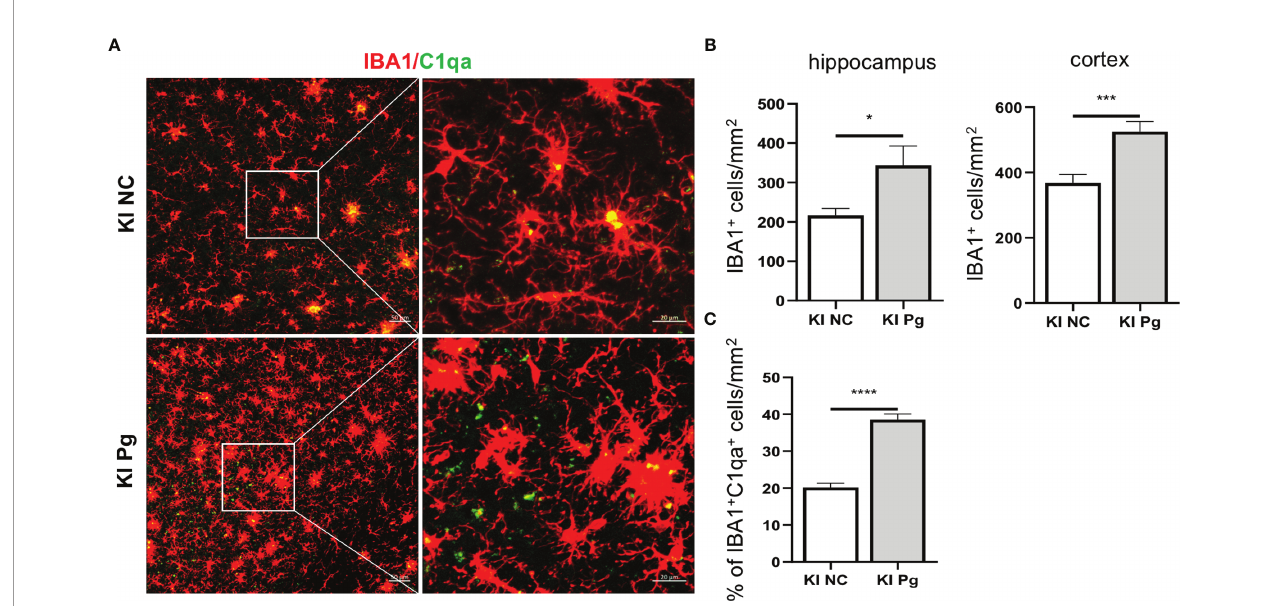
FIGURE 5 | Pg activates microglia in App KI mice and co-localize with complement C1q. Brain sections from 6-month-old non-infected and Pg-infected App KI mice were immune-stained with antibodies against IBA1and C1qa. (A) Representative Z-stack images of brain sections depicting the spatial association between microglia (red) and C1qa (green). (B) Quanti fi cation of IBA1 + cells in the hippocampus and cortex regions. n=6-7 mice/group. (C) Percentage of IBA1 + C1qa + microglia in non-infected and Pg-infected App KI mice. Five representative micrographs of the cortex and hippocampus regions from each mouse were analyzed (n=5-7 mice/group). Data are expressed as mean ± SEM. * P < 0.05, *** P < 0.001, **** P < 0.0001 by unpaired Students t